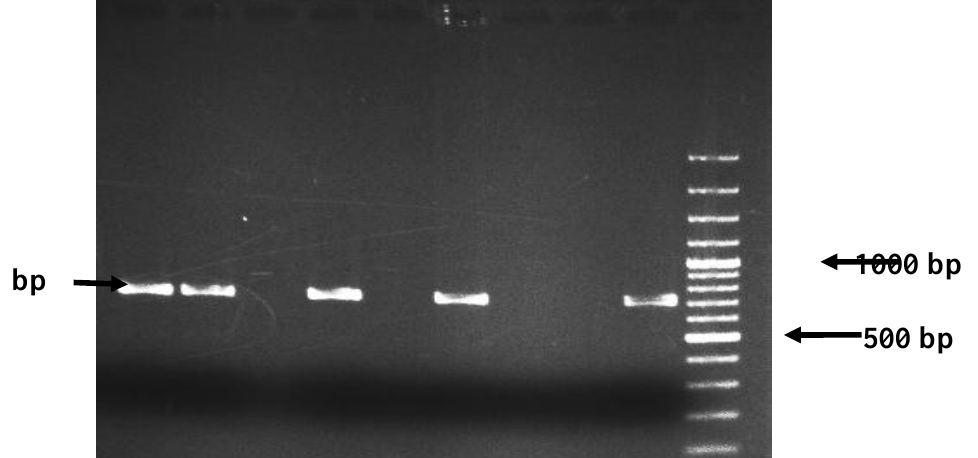
Figure 3: Detection of T. annulata in blood samples by the PCR assay. The figure shows results of agarose gel electrophoresis of amplified DNA extracted from blood samples obtained in the present study. Lanes 1, 2, 4 and 6 infected blood samples; lanes 3, 5 and 7 non-infected blood samples; lanes 8 & 9 controls negative & positive respectively and lane 10 molecular size